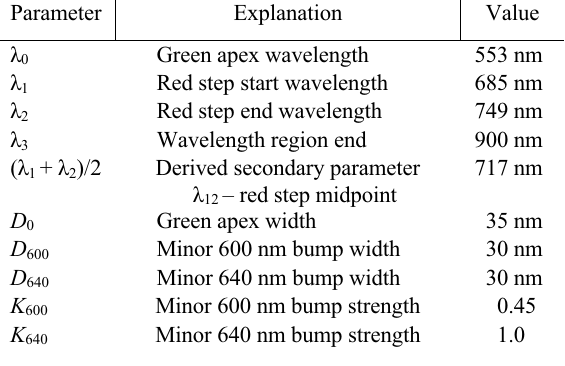
Table 4. Common wavelength­related parameter values of the compact model obtained by the fitting of experimental data of seven data sets